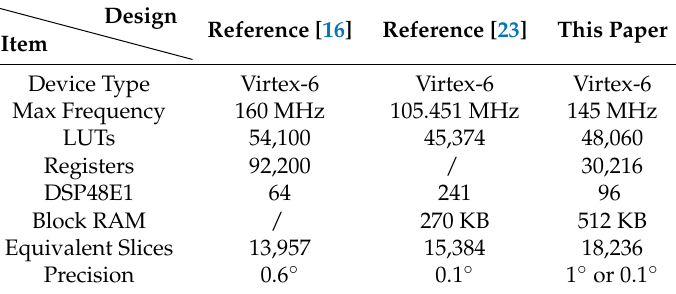
Table 4. Different implementations in FPGA.